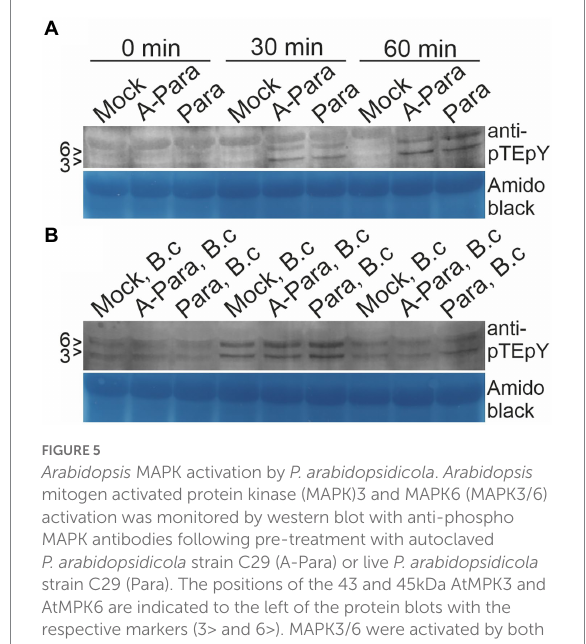
FIGURE 5 Arabidopsis MAPK activation by P. arabidopsidicola . Arabidopsis mitogen activated protein kinase (MAPK)3 and MAPK6 (MAPK3/6) activation was monitored by western blot with anti-phospho MAPK antibodies following pre-treatment with autoclaved P. arabidopsidicola strain C29 (A-Para) or live P. arabidopsidicola strain C29 (Para). The positions of the 43 and 45 kDa AtMPK3 and AtMPK6 are indicated to the left of the protein blots with the respective markers (3 > and 6 >). MAPK3/6 were activated by both A-Para and Para pre-treatment at 30 and 60 min. (A) Leaf samples were collected at 30 and 60 min after A-Para or Para pre- treatment. (B) Leaf samples were collected at 30 and 60 min after Botrytis infection was applied to plants which has been pre- treated with A-Para or Para for 3 days. Equal loading was confirmed by amido black staining. Three independent experiments were repeated with the same result, of which representative results are shown. B.c: Botrytis cinerea